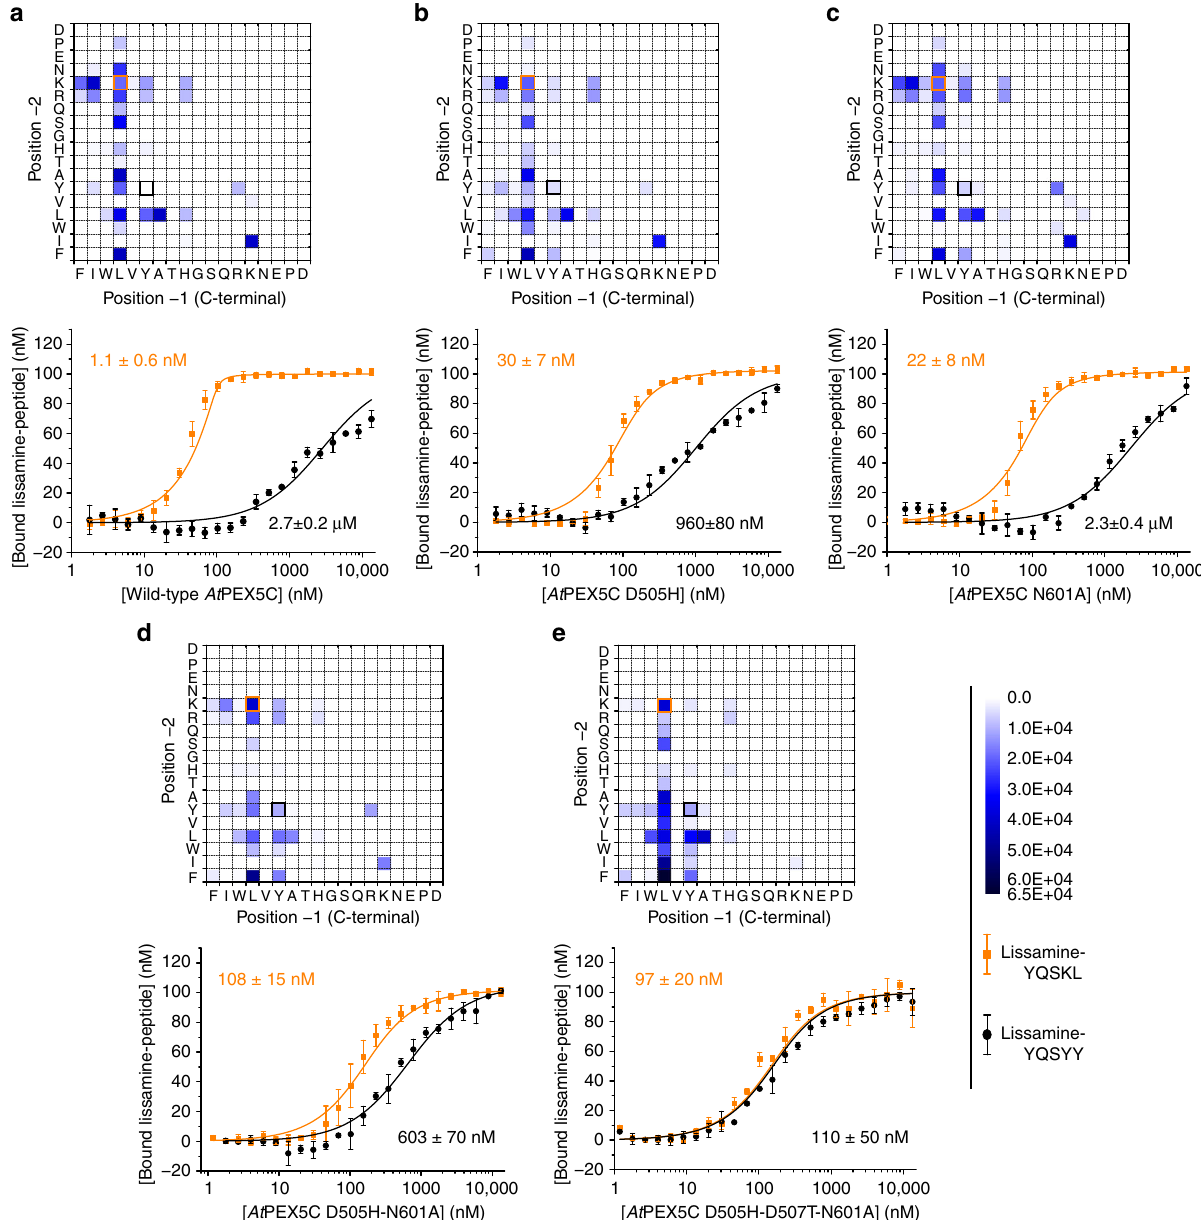
Fig. 2 Peptide-binding selectivities for wild-type and key At PEX5C variants. Heat maps (showing area-under-extracted ion chromatograms (EICs) for pulled-down peptides are shown, along with fl uorescence anisotropy results using lissamine-YQSKL ( orange ) and lissamine-YQSYY ( black ). Darker blue indicates increased area-under-EIC in the LC-MS analysis. a Wild-type At PEX5C. b At PEX5C D505H. c At PEX5C N601A. d At PEX5C D505H-N601A. e At PEX5C D505H-D507T-N601A. Across the series a – e , an increased af fi nity of protein variants to lissamine-YQSYY is observed, along with a decrease in af fi nity for lissamine-YQSKL. The curves represent non-linear least squares fi tting to a 1:1 binding model, fi tted using OriginPro. Error bars represent standard deviations of triplicate